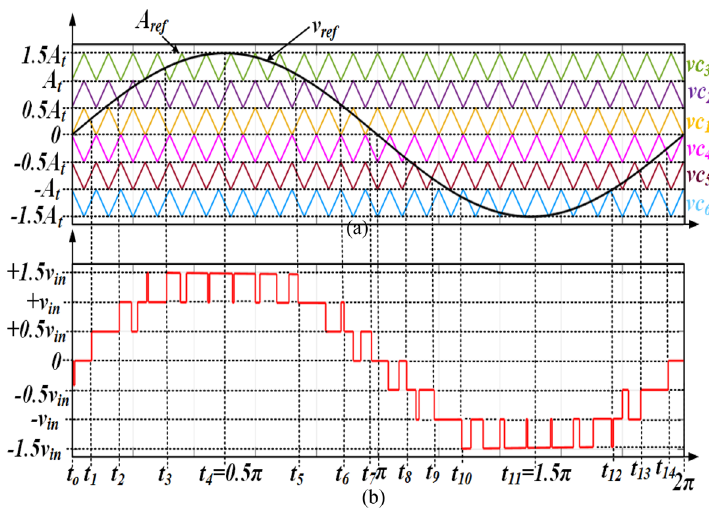
Figure 4. Modulation Technique ( a ) PD-PWM and ( b ) corresponding 7L